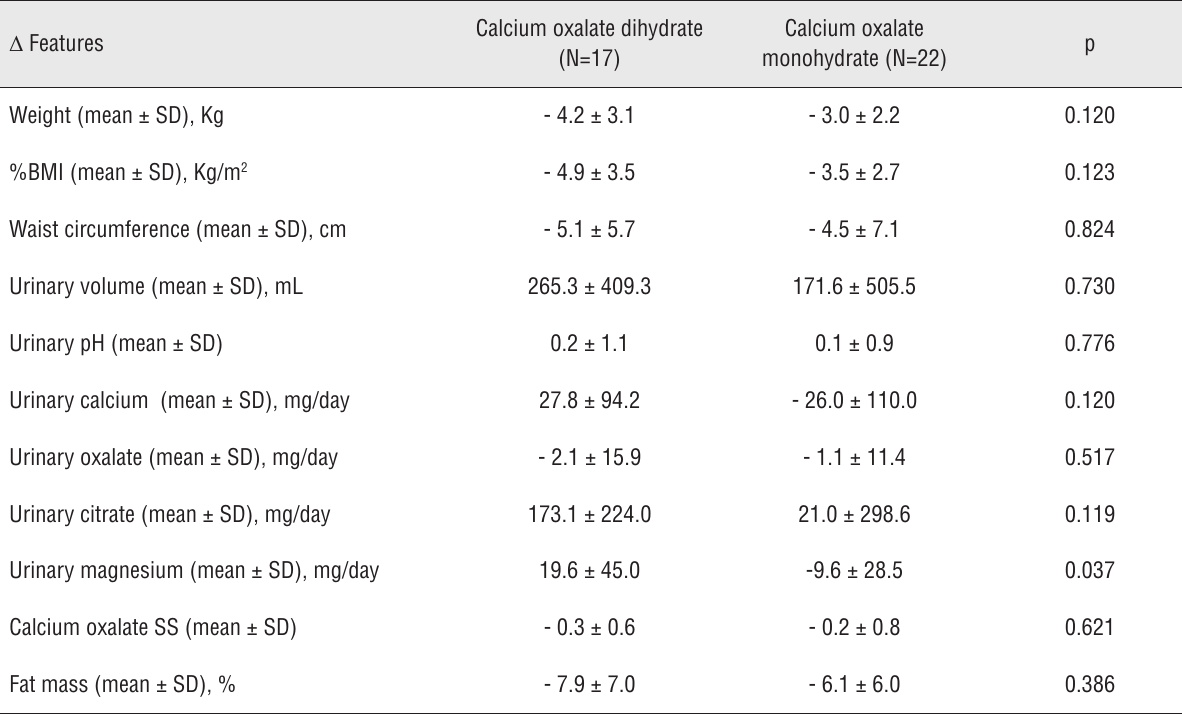
Supplementary Table 1 - Comparison of variations of 24-hour urinary lithogenic parameters after low calorie diet between groups of calcium oxalate stone composition.